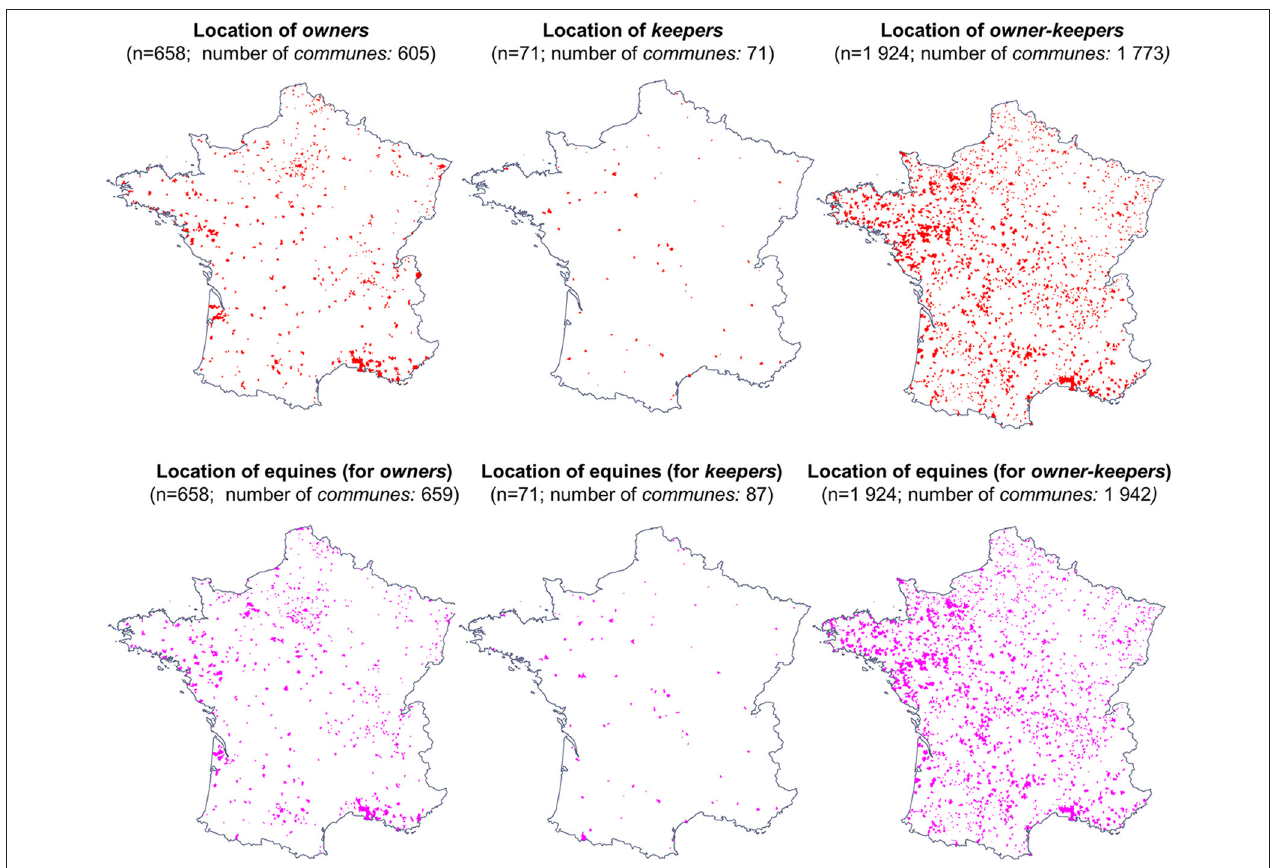
FIGURE 3 | Residence and holding communes of respondents when the two communes were located in mainland France (a dot in a commune indicates that there is at least one owner, one keeper, one owner–keeper, or one equine in this commune).